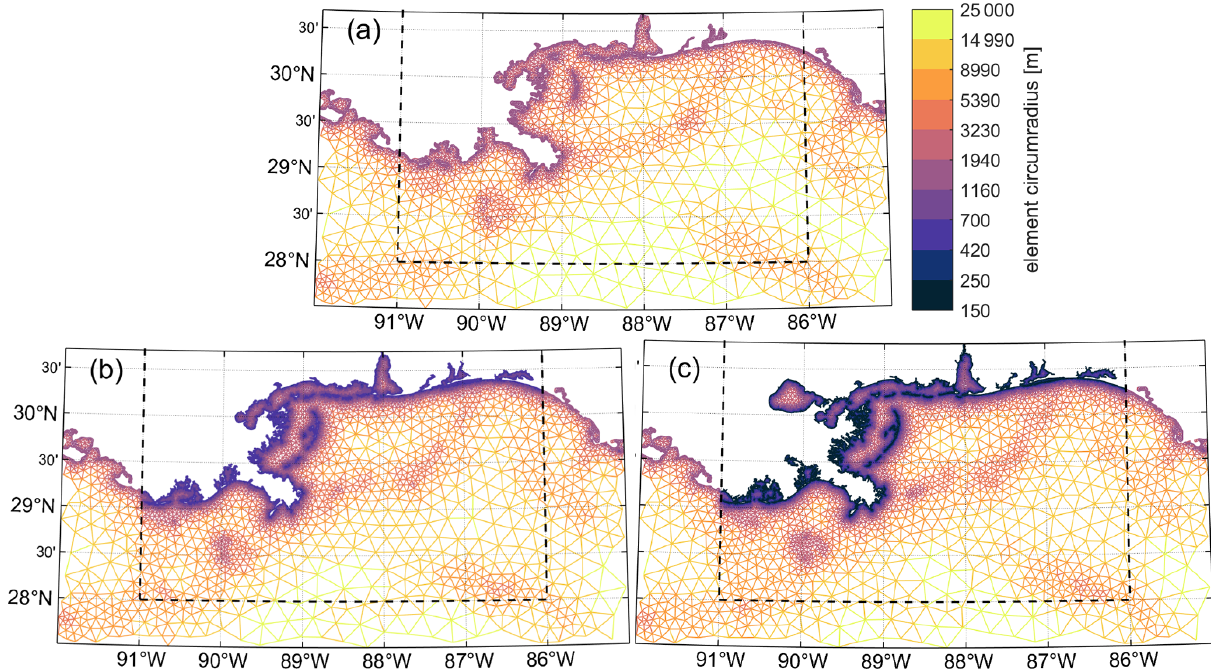
Figure 2. Comparisons of mesh triangulation and resolution (defined as the element circumradius on a Lambert conformal conic projection) in the Hurricane Katrina landfall region around Louisiana–Mississippi, USA. (a) MinEle = 1.5km (default TLS-B global mesh design), (b) MinEle = 500m local mesh refinement, (c) MinEle = 150m local mesh refinement. The black dashed boxes indicate where the local mesh refinement was